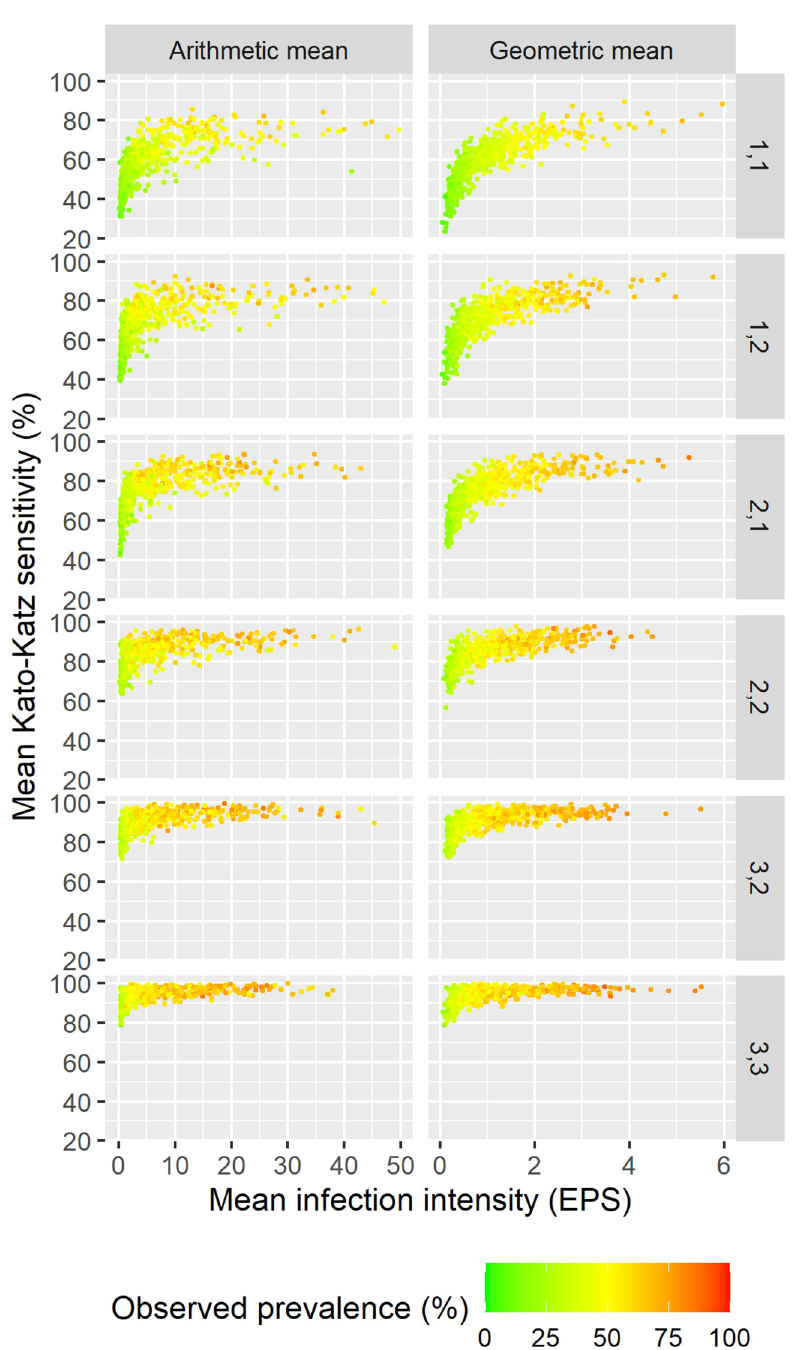
Fig 1. Overall sensitivity of Kato-Katz in relation to geometric and arithmetic mean of total population for six different sampling schemes in simulations with 50 individuals per location. The sampling scheme is denoted on the right side with the first number referring to the number of stool samples and the second to the number of slides per stool sample. Observed prevalence is shown in color and EPS refers to eggs-per-slide.